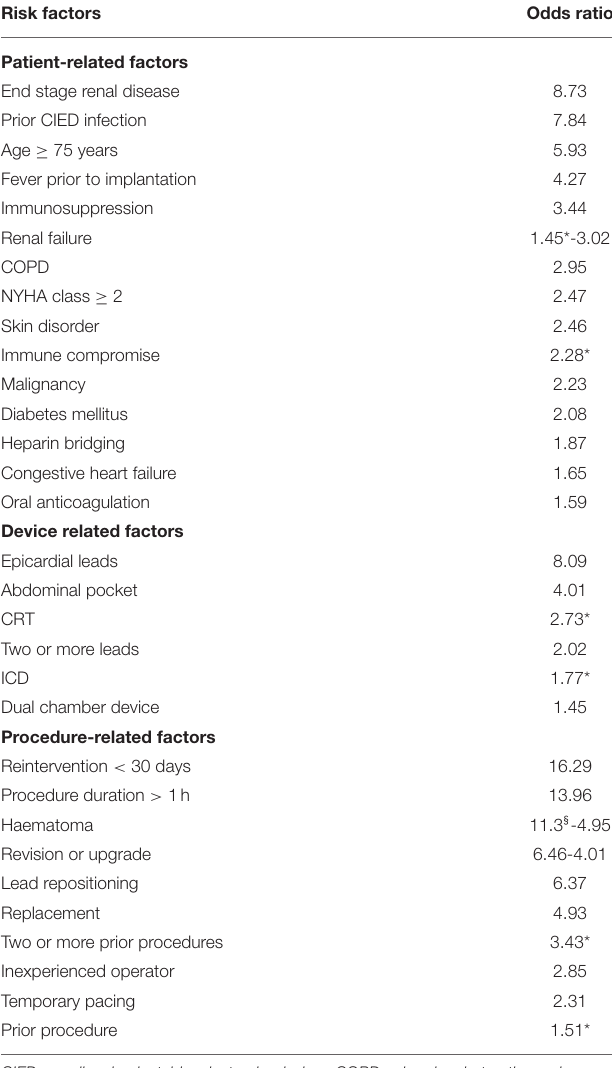
TABLE 1 | Major risk factors for CIED